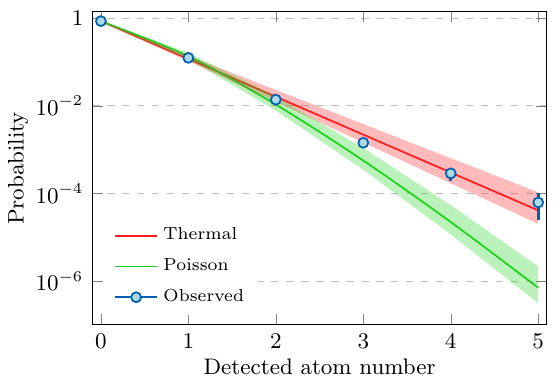
Figure 2: Counting statistics of one output mode of the atom pair source. The red line shows a thermal distribution with a mean detected atom number of 0.158, equal to that measured in the experiment. The red band shows a range of thermal distri- butions with detected atom numbers between 0.135 and 0.2. The green line shows a Poisson distribution with the same mean. The green band shows a range of Poisson distributions with detected atom numbers between 0.135 and 0.2. The error bars on the data points denote the statistical uncertainty (standard deviation) estimated with the bootstrapping method. Wherever the error bars are not visible, they are smaller than the point size. The populations are expressed as probabilities, therefore P ( 0 ) <